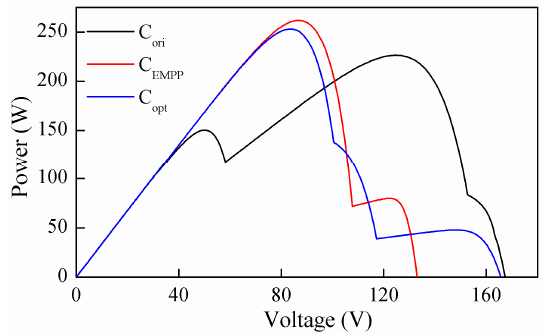
Figure 15. ( a ) Primary configuration C ori ; ( b ) optimized configuration C EMPP ; and ( c ) optimized configuration C opt .